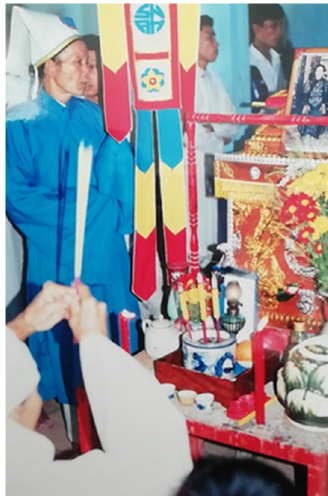
Figure 2. The altar, memorial tablet and picture of the dead in front of the coffin, managed by Bình